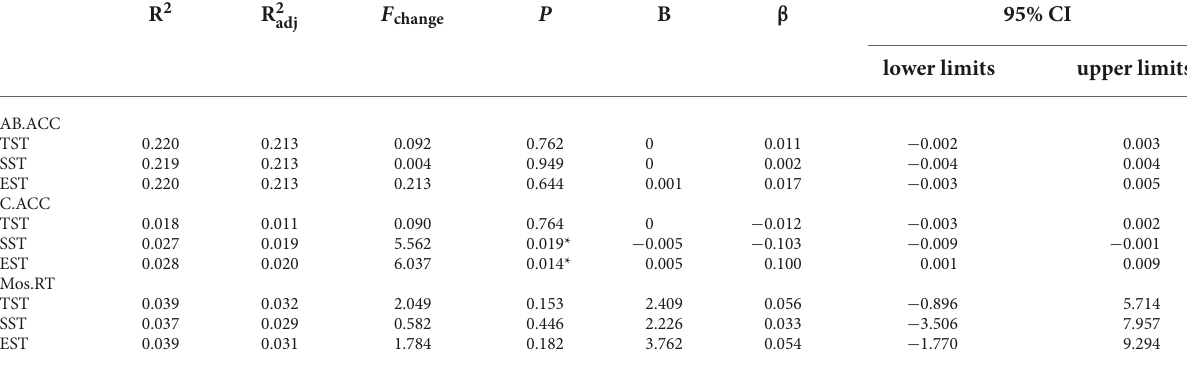
TABLE 3 Regression analysis for the associations between sedentary behaviors and cognitive flexibility ( N =